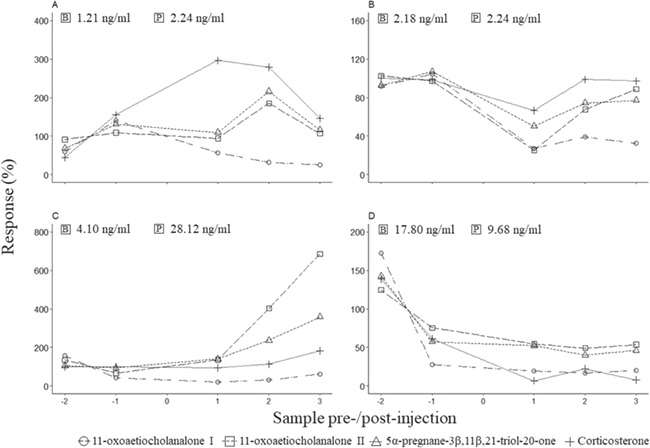
The percentage uGCM response in one ACTH injected female (A) and male (C), as well as one control female (B) and male (D). The ACTH and Ringer’s solution administration occurred at sample 0. Also shown is the absolute baseline (B) and peak post injection (P) uGCM concentrations for the most appropriate enzyme immunoassay chosen (11-oxoaetiocholanalone II).